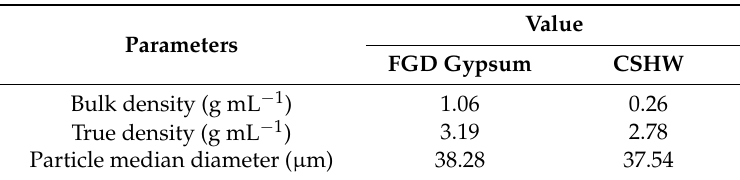
Table 1. Main physical characteristics of flue gas desulfurization (FGD) gypsum and calcium sulfate hemihydrate whisker (CSHW).